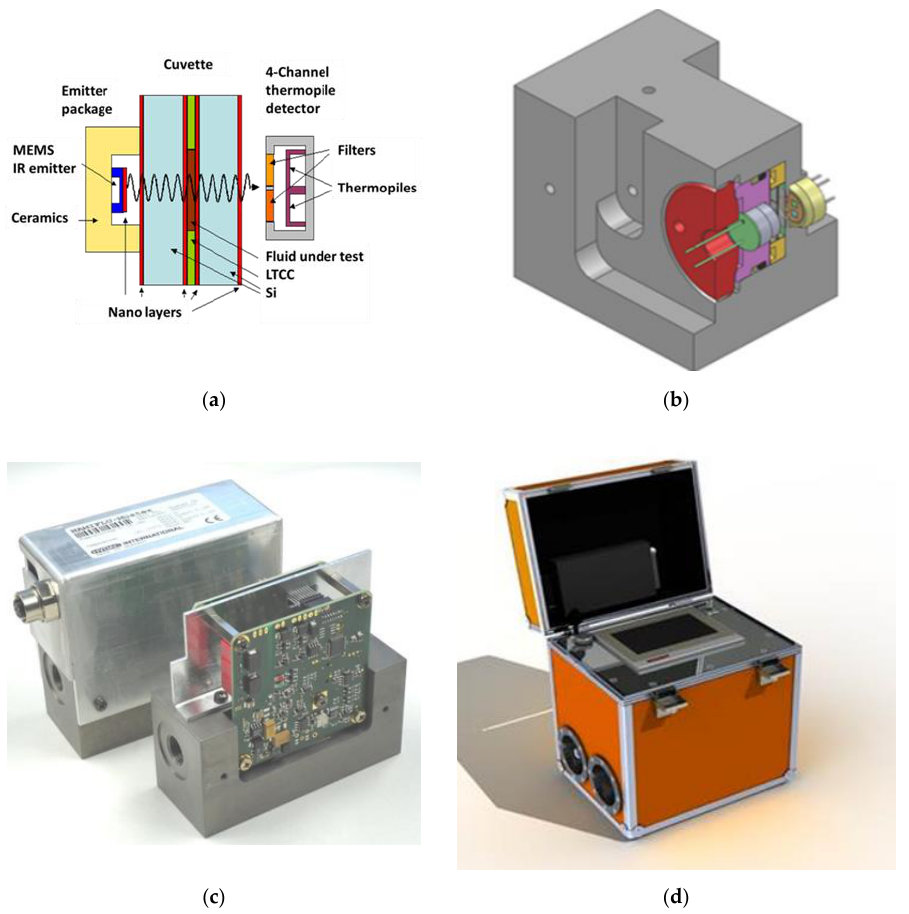
Figure 7. ( a ) Micro-cuvette containing the fluid under test and fitted in between a MEMS IR emitter and a 4-thermopile sensor array with narrow band filters transparent at the wavelengths indicated in Figure 5b [10,11]. ( b ) Mechanical set-up containing the MEMS IR emitter, the micro-cuvette (yellow) and the thermopile detector array inside a common metal block (grey) that can withstand the high pressures inside aviation hydraulic systems [10,11]. ( c ) Fully assembled MIR sensor system featuring the internal electronics and fluidic connectors [10,11]. ( d ) HYDAC Ground Lab for on-site hydraulic fluid monitoring on airfields containing the MIR sensor system shown in ( a – c ), and an additional particle contamination detector [9,22].